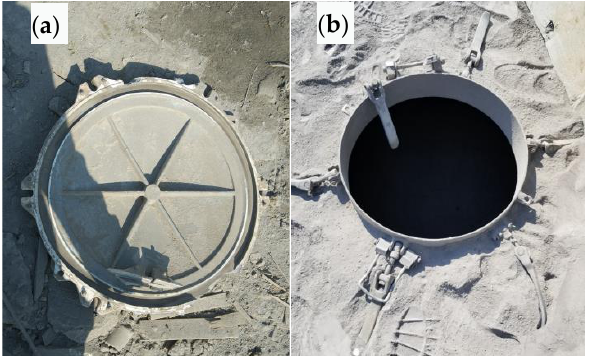
Figure 1. Manhole cover and manhole ring: ( a ) broken cover, ( b ) manhole ring.